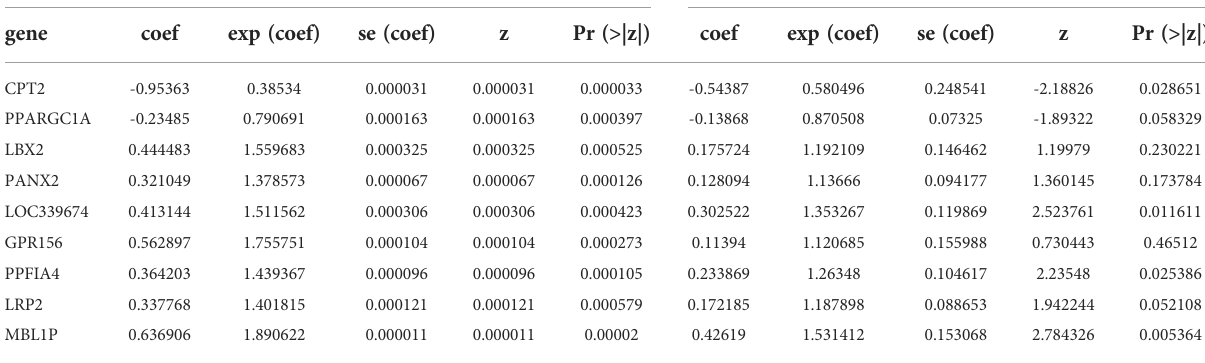
TABLE 1 Univariate and Multivariate Cox analysis